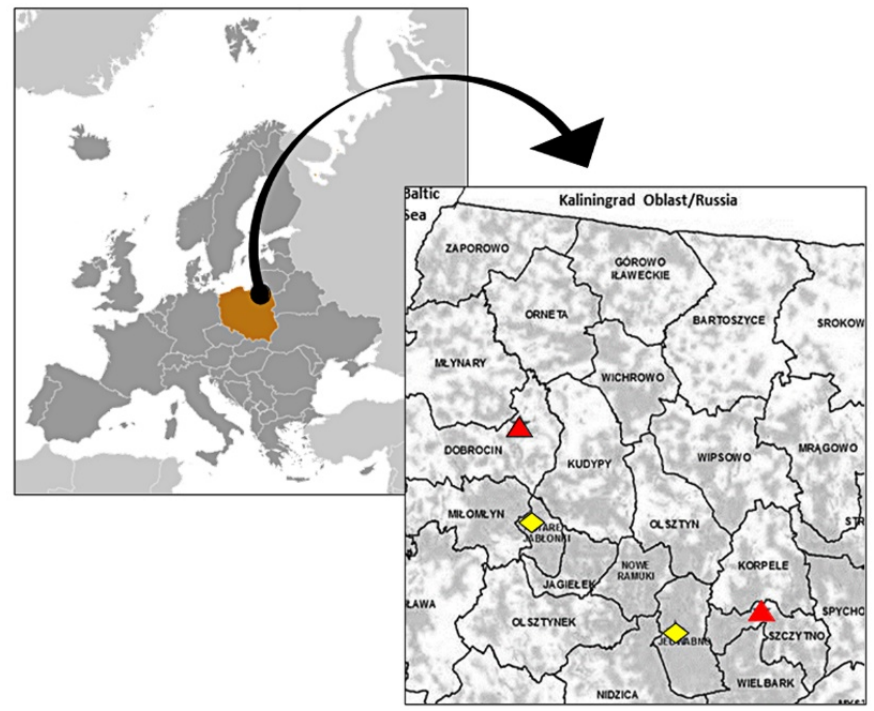
Figure 1. Localities of forest districts of the Olsztyn Regional Directorate of State Forests (RDSF) in Poland) with selected Douglas fir stands situated in broadleaf-conifer mixed forest sites (yellow squares) and broadleaf forest sites (red triangles); image with forest district borders and forest cover (gray areas) adapted from the RDSF map.